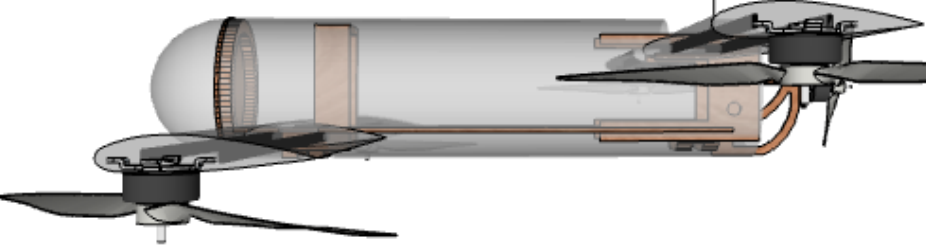
Figure 9. An overview of the Elka1Q drone—side view.